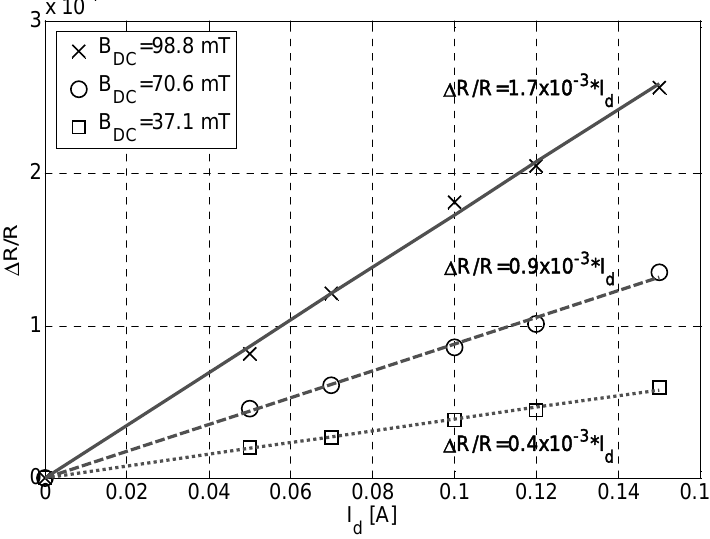
Figure 7. The relative resistance change of the IJP strain gauge as function of the driving current.